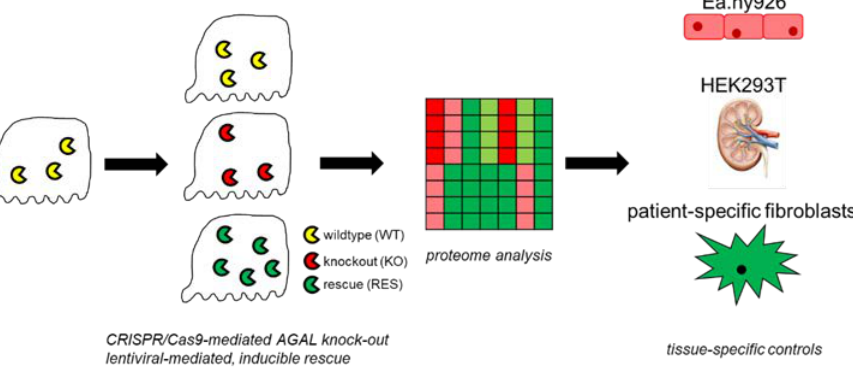
Figure 1. Overview of the study procedure. CRISPR/Cas9-mediated AGAL ( α -galactosidase A) knockout (KO) podocytes were compared to wild-type (WT) and lentiviral-mediated rescued (RES) cells via proteome analysis. Expression of dysregulated proteins of interest was further analyzed in endothelial (Ea.hy926), kidney epithelial (HEK293T) cells and patient-specific